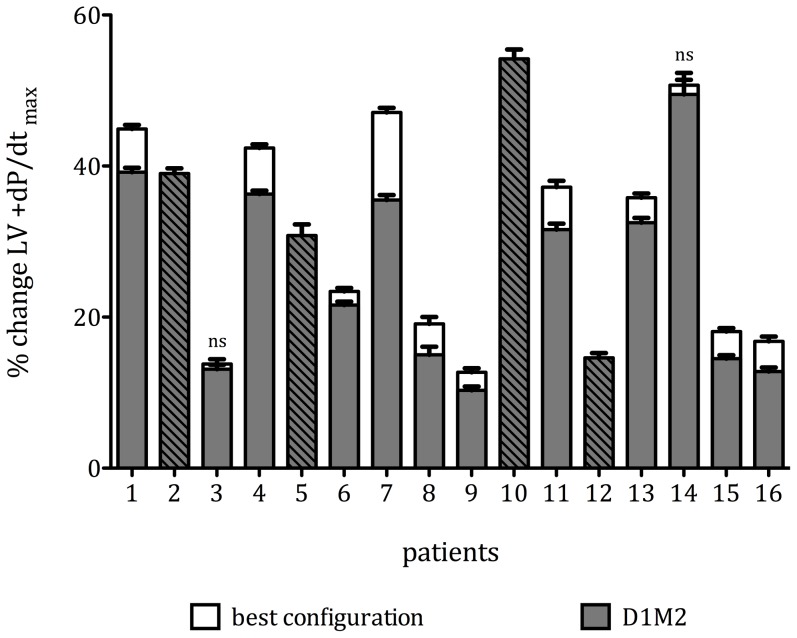
Comparison of optimal and distal LVPCs - Individual results in increment in mean %ΔLV +dP/dtmax (±95% confidence interval) in all patients in the optimal (white) and D1M2 (grey) pacing configuration (p<0.0001 for all intraindividual differences except for patients 3 and 14 (ns).Striped bars indicate those 4 patients in whom D1M2 exhibited maximal increase in %ΔLV +dP/dtmax.